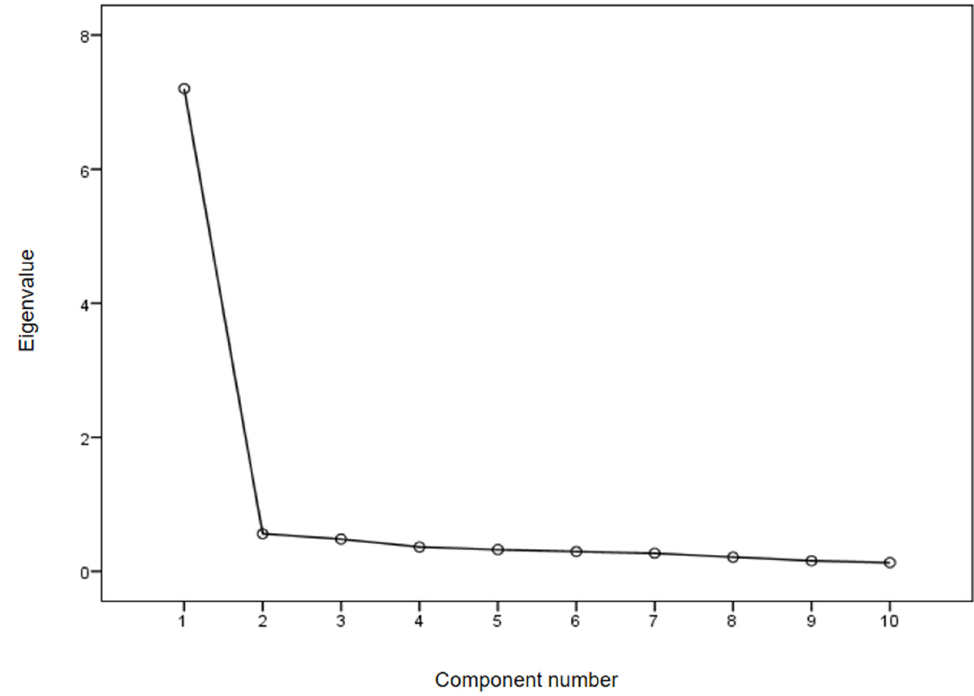
Figure 1. Dimensions in the scree plot. Table 2. Rotated component